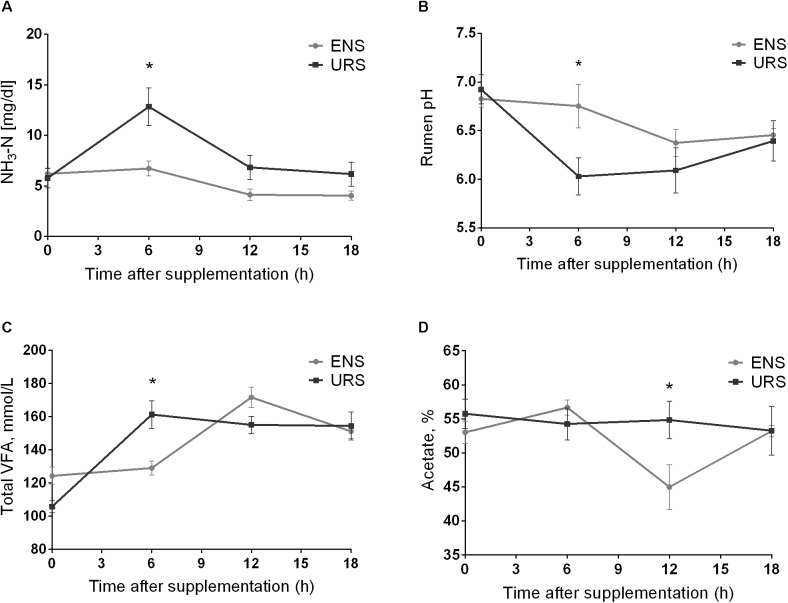
Mean and standard error of mean of ruminal ammonia (NH3-N) concentration (A), pH values (B), total volatile fatty acid (VFA) rumen concentration (C) and Acetate proportions (D) during a 18 h period in grazing Nellore Steers after a long time (13 months) of supplementation with encapsulated nitrate (ENS) or Urea (URS). ∗supplement effect and time effect interaction (P < 0.05) as obtained with Tukey’s test.